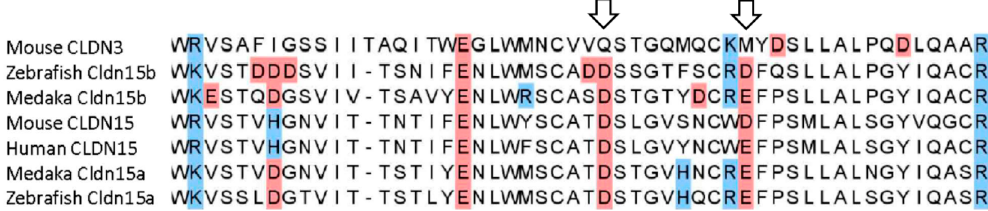
Figure 11. Alignment of the first extracellular loop of CLDN15 from human and mouse, and the orthologues from Japanese medaka and zebrafish shows that the residues critical to pore formation (D55 and D64) are found in both teleost Cldn15 paralogues. There are also di ff erences from mammalian CLDN15; for example, both medaka Cldn15a and Cldn15b have an R63 residue and Cldn15a has an added H60. Amino acids are highlighted in red when acidic and in blue when basic. Arrows marks aspartic acids (D55 and D64), which are found to be important for cation and the water pore function of CLDN15 [11,12,15,16]. Mouse CLDN3 has been classified as a barrier protein and included as a reference. Sequences used: Human CLDN15: Acc. No. NP_001172009; Mouse CLDN15: Acc. No. NP_068365; Mouse CLDN3: NP_034032; Medaka Cldn15a: XP_004079873; Medaka Cldn15b: XP_004076514; Zebrafish Cldn15a: NP_956698; Zebrafish Cldn15b: NP_001035404.